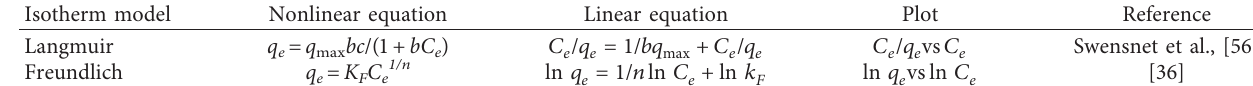
Table 3: Langmuir and Freundlich parameters extracted from isotherm models.